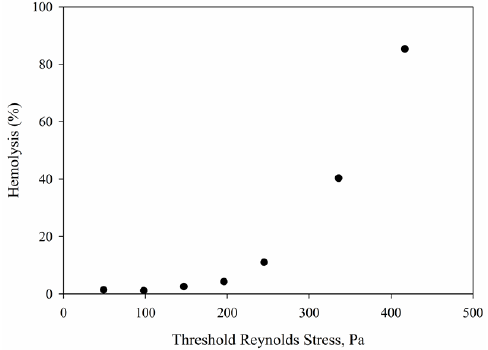
Figure 5. Relationship of hemolysis to threshold Reynolds stresses in Couette viscometer for all experiments (450 to 50 Pa).